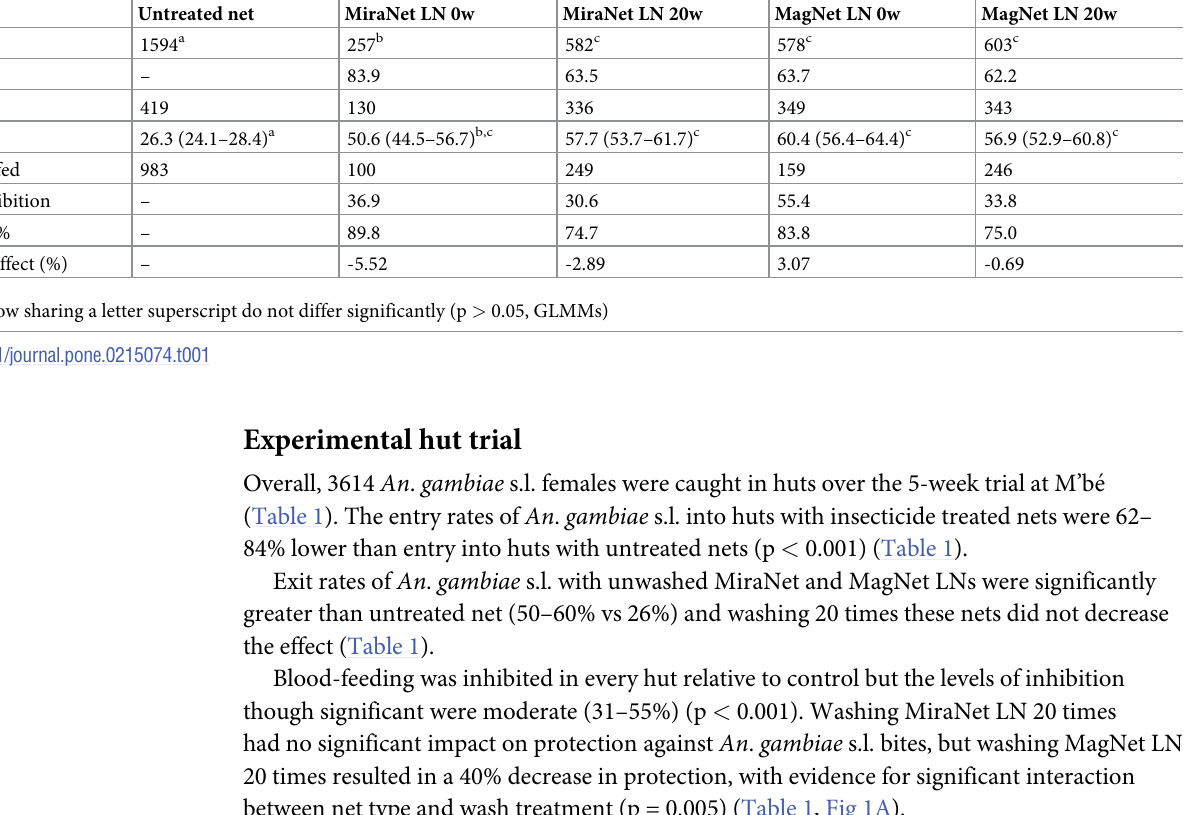
Table 1. Experimental hut trial results against pyrethroid resistant An . gambiae s.l.